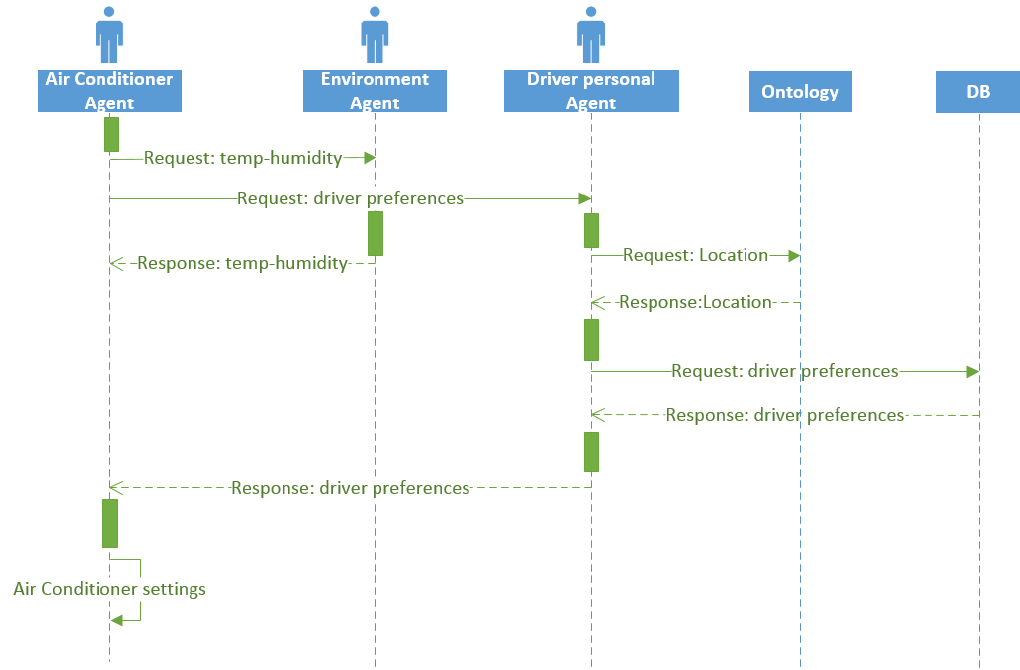
Figure 6. Sequence diagram of the air-conditioner setting task.